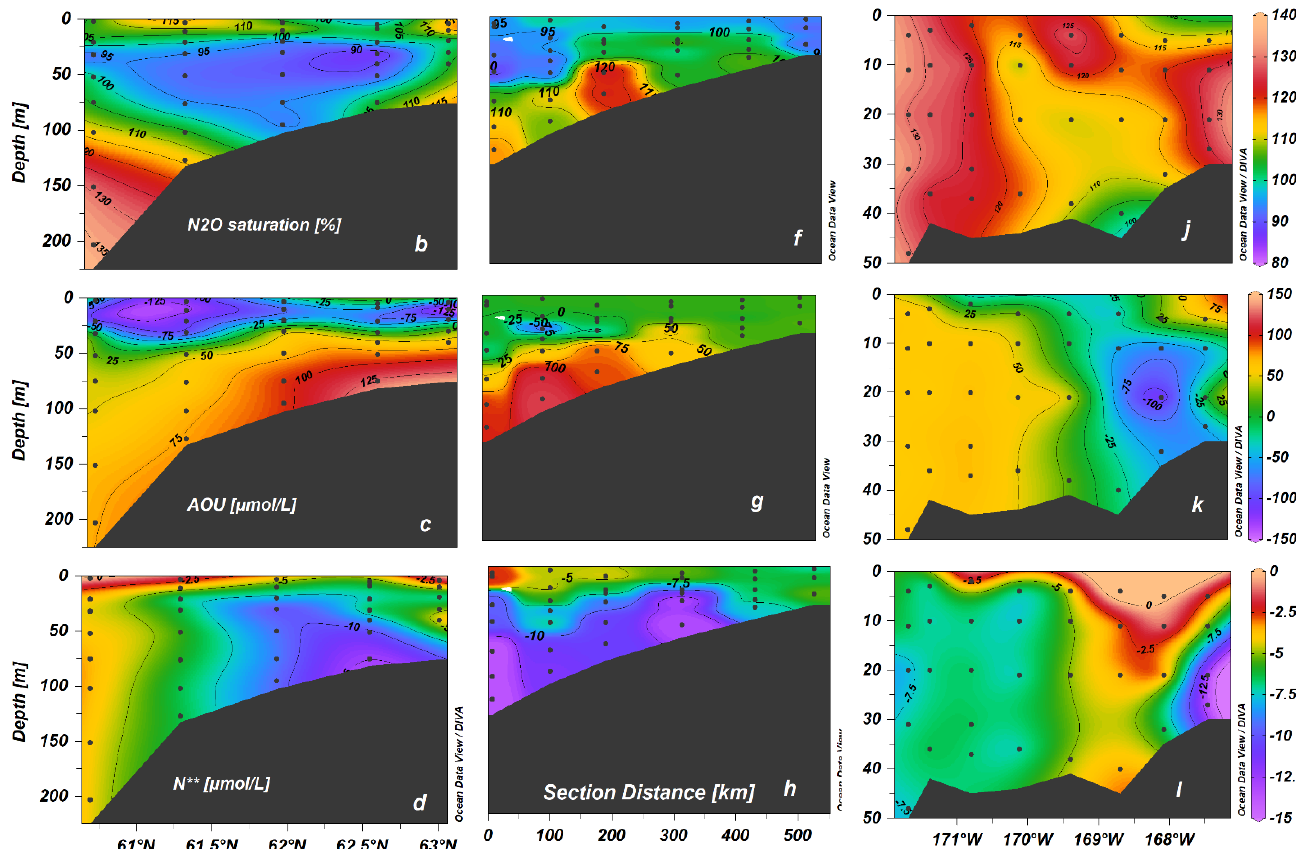
Figure 4. The vertical distribution of N 2 O concentration, N 2 O saturation, AOU, and N** in sections BL( a – d ), BS ( e – h ), and BN ( i – l ) in summer 2012. On the basis of the sampling locations, the BL, BS, and BN sections take latitude, distance, and longitude as their horizontal coordinate, respectively. Due to the difference in bottom depth, the BL and BS sections use the same depth coordinate (0–250 m) and the BN section use another depth coordinate (0–50 m).